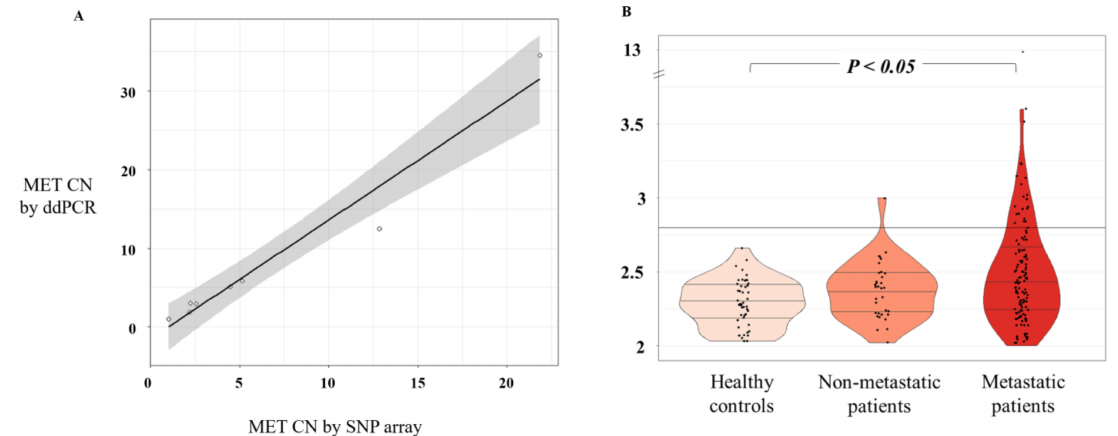
Figure 1. MET CN analysis. ( A ) Scatterplot representing correlation between MET CN in cancer cell lines determined by ddPCR versus single-nucleotide polymorphism (SNP) array ( n = 8) using Pearson’s correlation; ( B ) Plasma MET CN detected in healthy controls ( n = 49), non-metastatic patients ( n = 34), and metastatic patients ( n = 140) using the Mann–Whitney–Wilcoxon